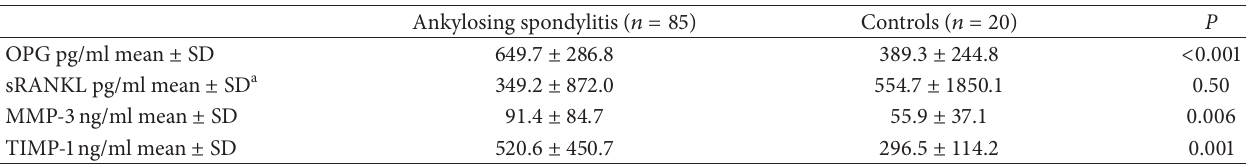
Table 1: Serum level of soluble receptor activator of NF- 𝜅 B ligand (sRANKL), osteoprotegerin (OPG), matrix metalloproteinase 3 (MMP-3), and tissue inhibitor of metalloproteinase 1 (TIMP-1) in patients of ankylosing spondylitis versus